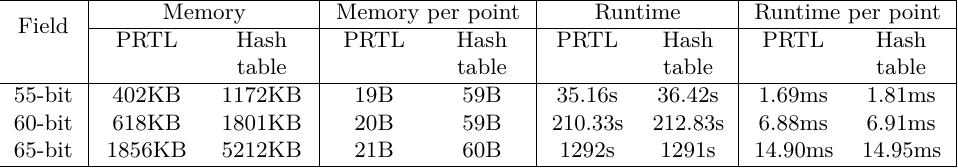
Table 5: Runtime and the memory cost for attacking ECDLP using PRTLs and hash tables.